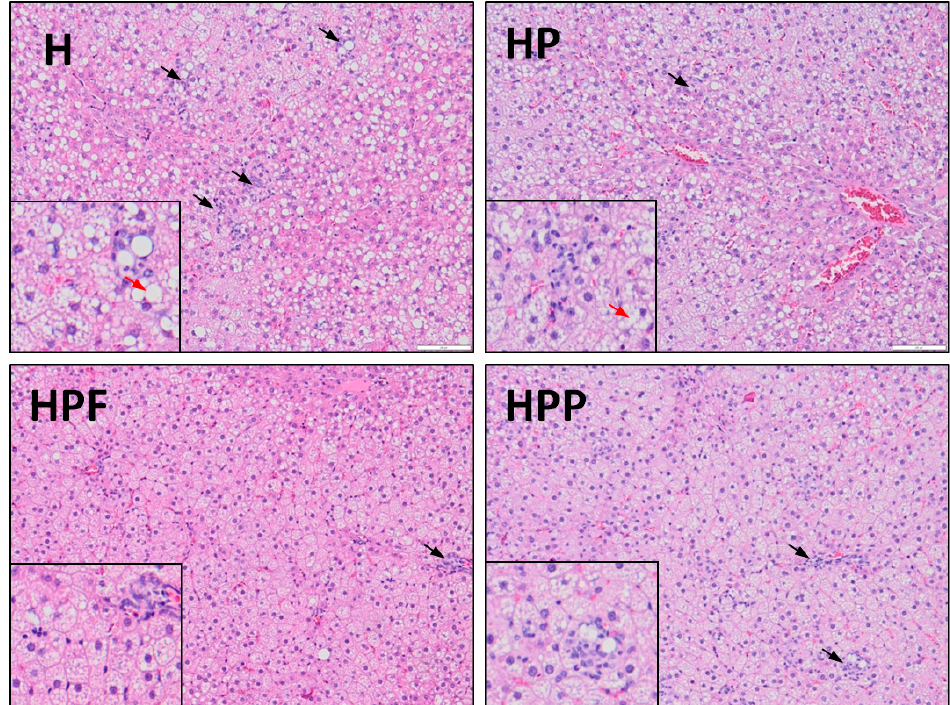
Figure 3. Hepatic histology in rats fed the experimental diets. H, control high-fat diet; HP, control high-fat diet enriched with raspberry polyphenol extract; HPF, control high-fat diet enriched with raspberry polyphenol extract and fructo-oligosaccharides; HPP, control high-fat diet enriched with raspberry polyphenol extract and pectin. (H) Liver with steatosis. Several inflammatory foci within the hepatic lobule (black arrow) and enhanced hepatocyte ballooning (red arrow). (HP) Reduced amount of inflammatory cells (black arrow) and mild ballooning of cells. Hepatocytes have